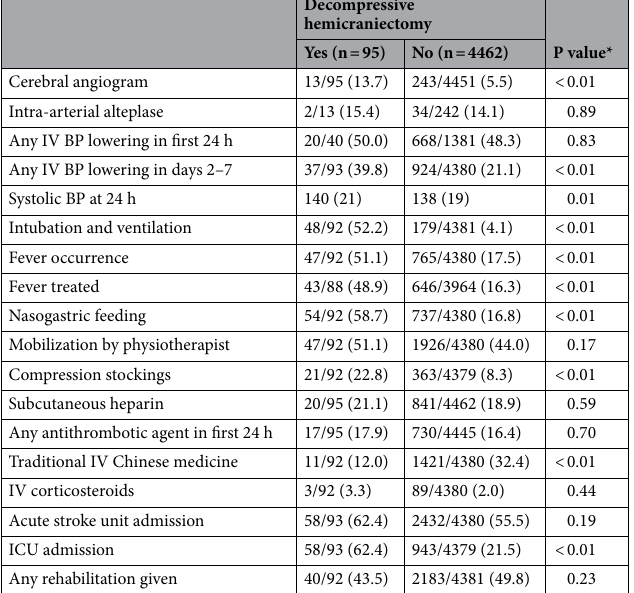
Table 3. Other management in the first 7 days of hospital admission. Data are n (%) or mean (SD). BP blood pressure, ICU intensive care unit, IV intravenous. *P values are based on χ 2 test, Fisher’s Exact test, or Wilcoxon